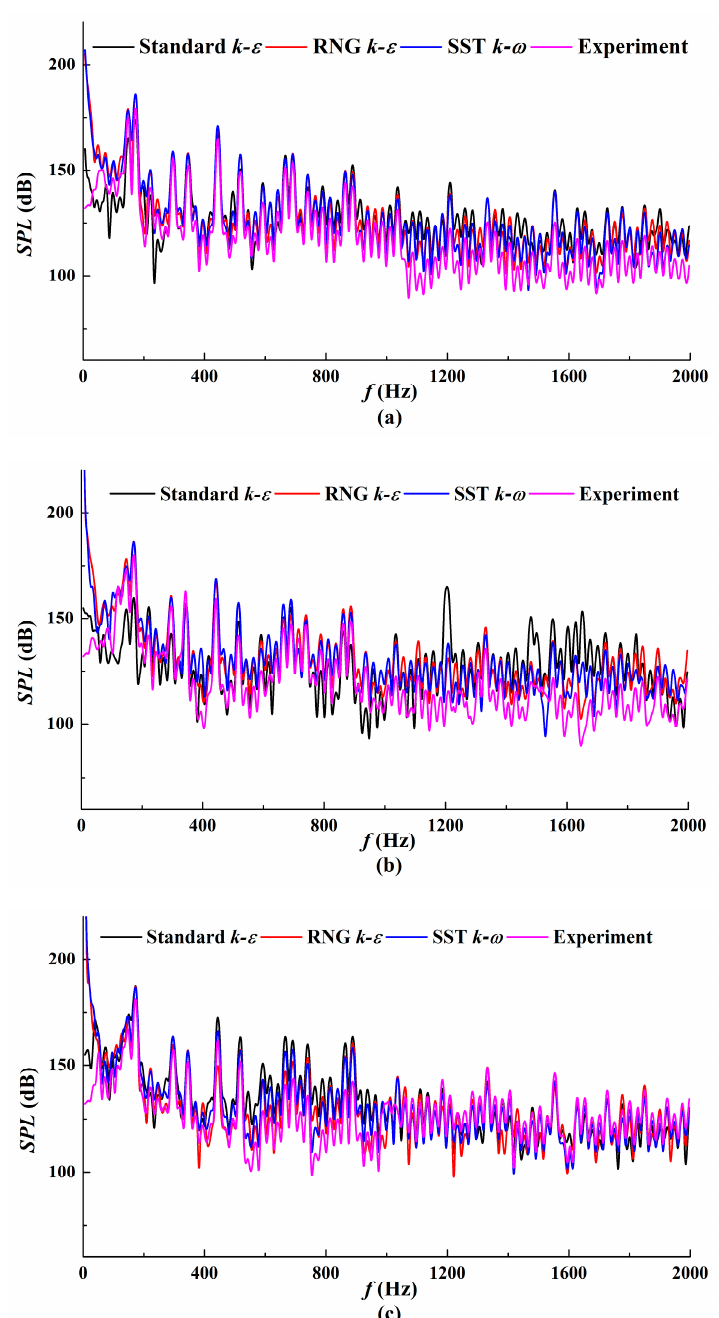
Figure 15. SPL at the discharge section for ( a ) 0.8 Q d , ( b ) 1.0 Q d , and ( c ) 1.2 Q d .